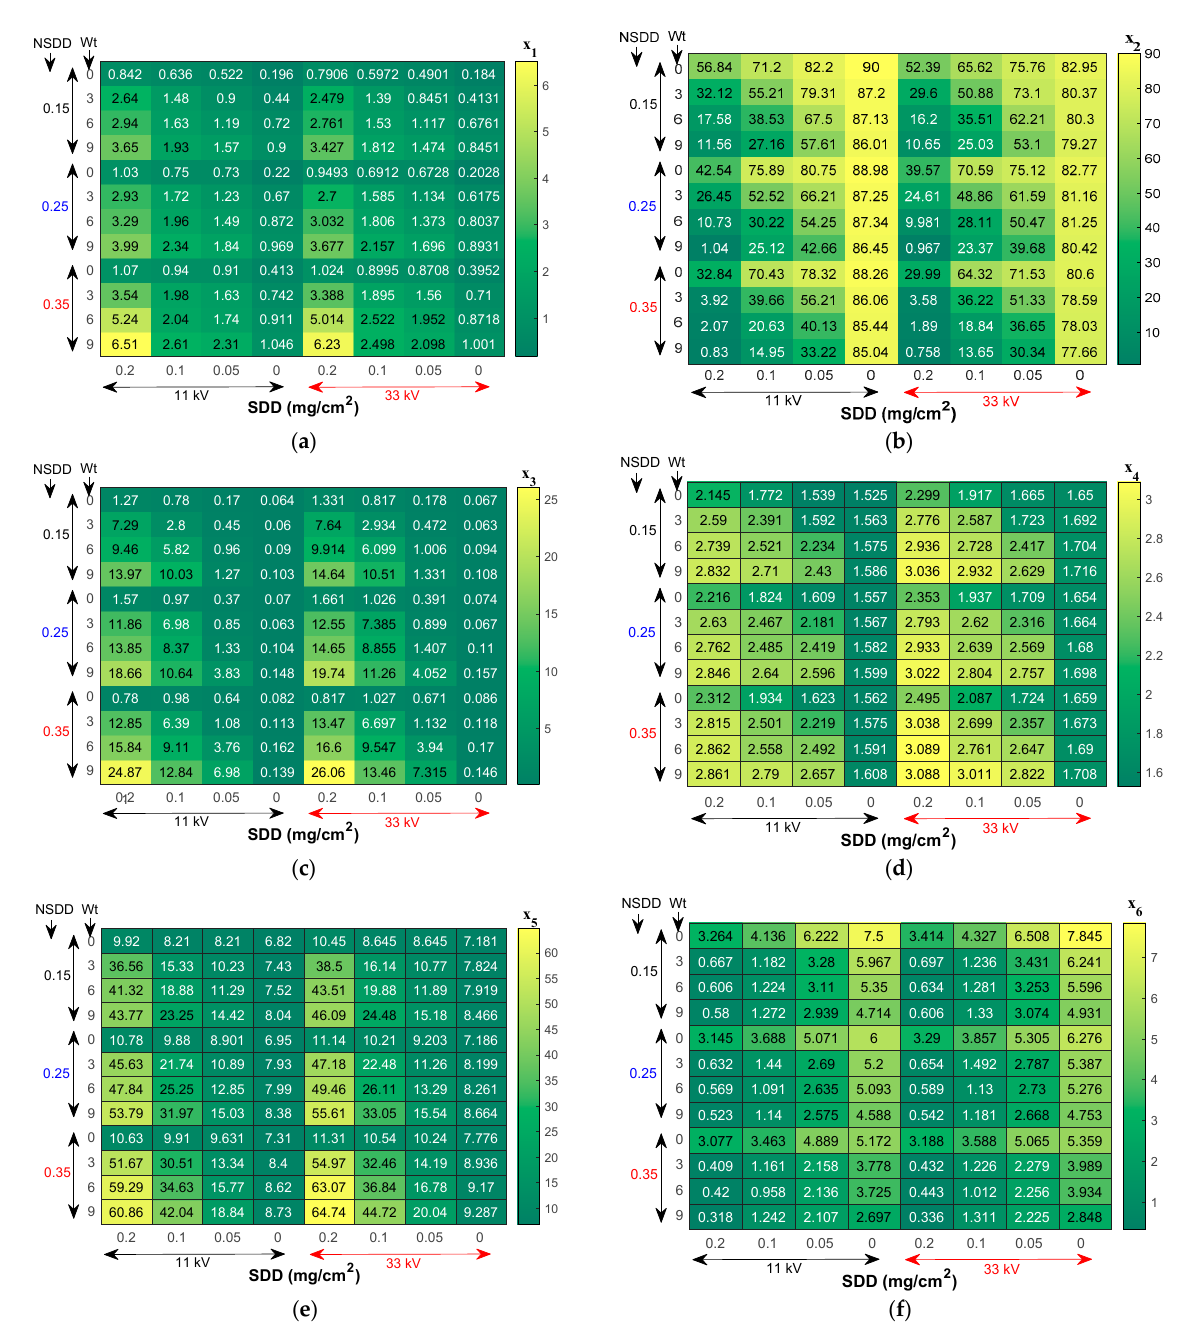
Figure 10. Leakage current indices of uniform polluted insulators under various wetting rate Wt and NSDD: ( a ) x 1 ; ( b ) x 2 ; ( c ) x 3 ; ( d ) x 4 ; ( e ) x 5 ; ( f ) x 6 .